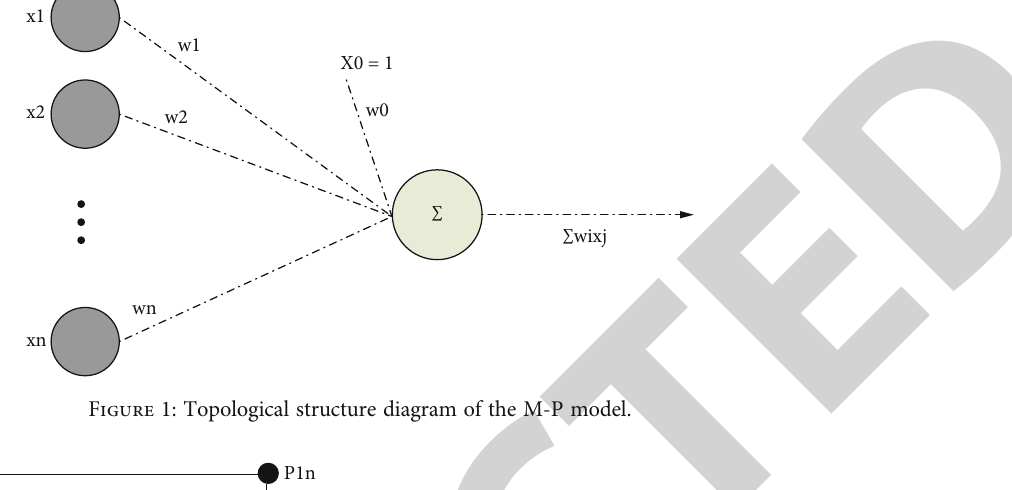
Figure 1: Topological structure diagram of the M-P model.